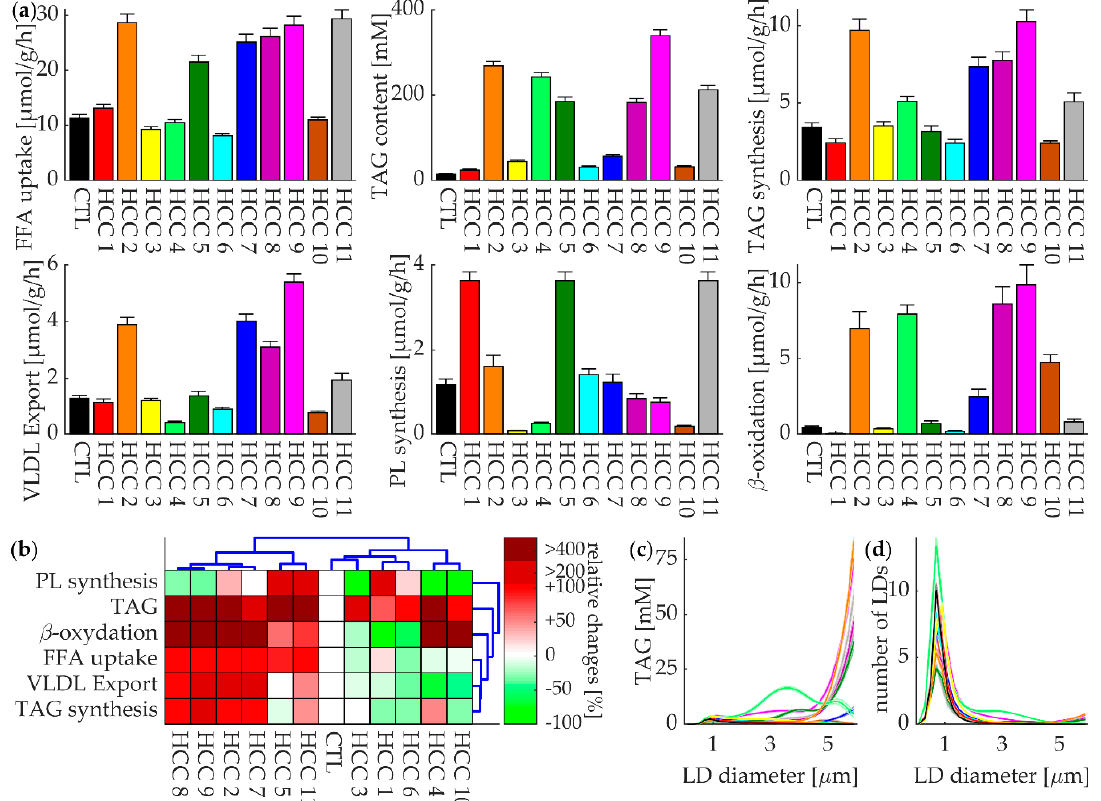
Figure 3. Metabolic profiles of lipid metabolism of individual HCCs based on simulated time-dependent changes of metabolites and fluxes. ( a ) 24-h mean values of six metabolic functions for the control (black column) and eleven HCCs. The error bars were obtained by randomly sampling the maximal activities of all model proteins from a 10% interval around the reference values, ( b ) clustering of the control and eleven HCCs based on similarities between their metabolic functions scaled as the percentage relative to the control. Values > 100% were replaced by a cut-o ff value of 100% to avoid having a single function with a very large increase relative to the control dominate the cluster analysis, ( c ) 24 h average TAG content stored in LDs of di ff erent size, ( d ) 24 h average size distribution of the